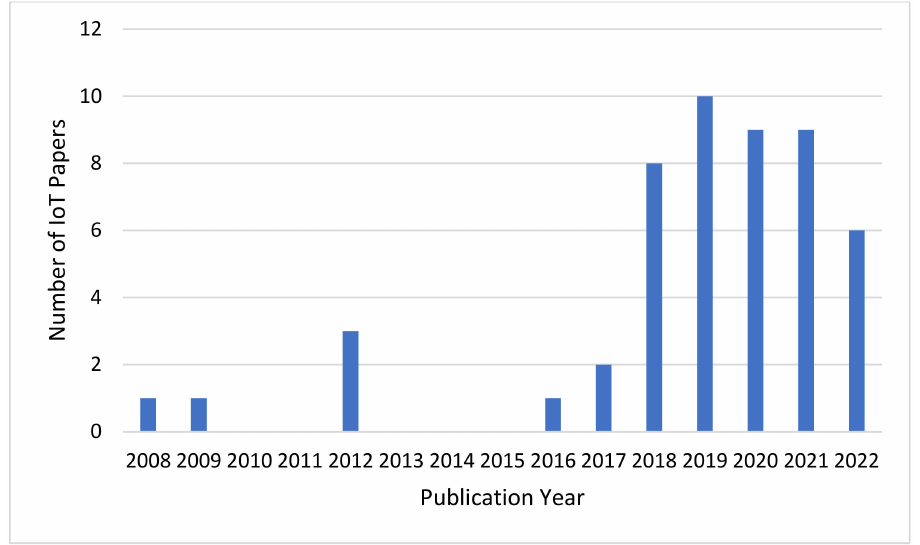
Figure 4. Number of IoT papers used versus their publication dates.